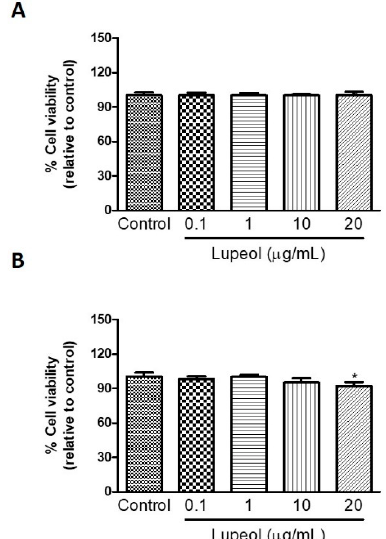
Figure 2. The viability of ( A ) epidermal keratinocytes and ( B ) dermal fibroblasts in response to lupeol. Cells were seeded in a 96-well plate and, after overnight attachment, different concentrations of lupeol were added, and the cells were left for 24 h at 37 °C. Cell viability was measured by MTT assay and calculated by a comparison of the values from the lupeol treatment group with the control group. Data are expressed as mean ± standard error of the mean (SEM). * p < 0.05 versus control group.